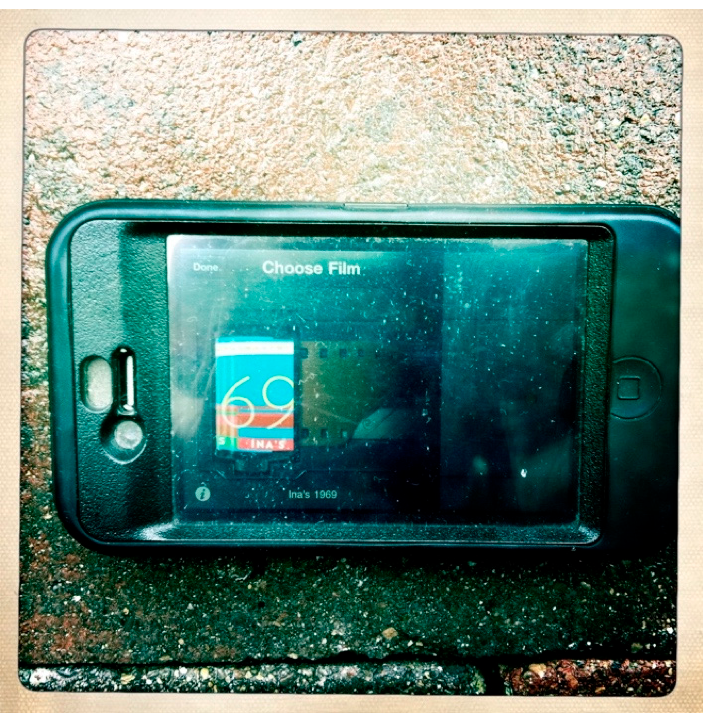
Figure 1. The smartphone and the Hipstamatic app (version 2011). Source: created by Rita Leistner (used with photographer’s permission).